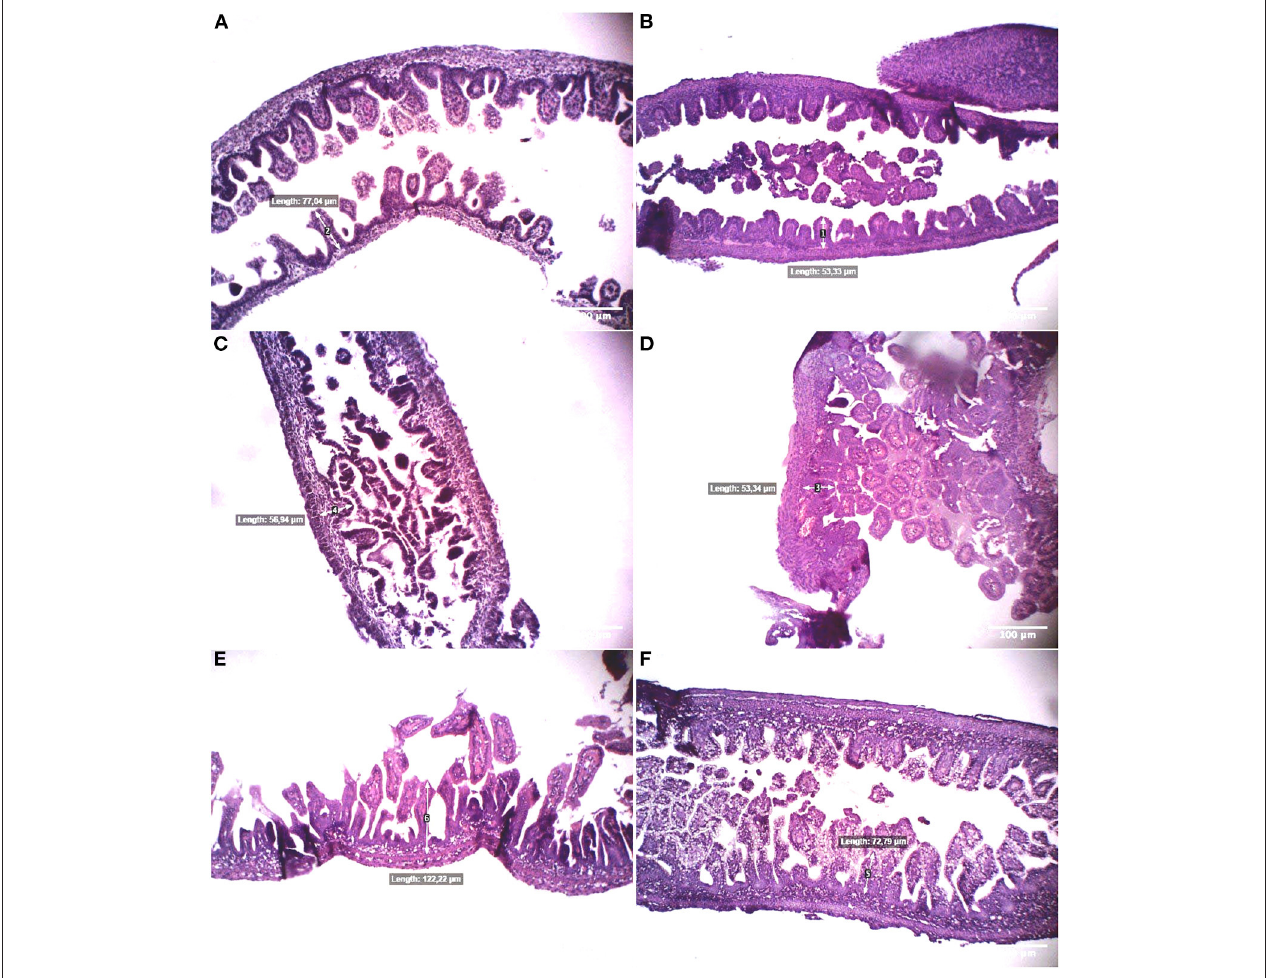
FIGURE 2 | Morphological presentation of villi height in hematoxylin-eosin (HE)-stained specimens of immature rabbit’s ileum at 24 days (A,B) , 26 days (C,D) , and 28 days postnatal (E,F) under objective magnification of 10 times. The left-sided figures show those of the spermine-treated group, and the right-sided figures represent the non–spermine group. It is shown that the spermine group’s ileal villi are longer than the non–spermine group and more regularly. The spermine group’s regular-shaped villi are configured by day 28 postnatal, whereas the non–spermine group remains discretely